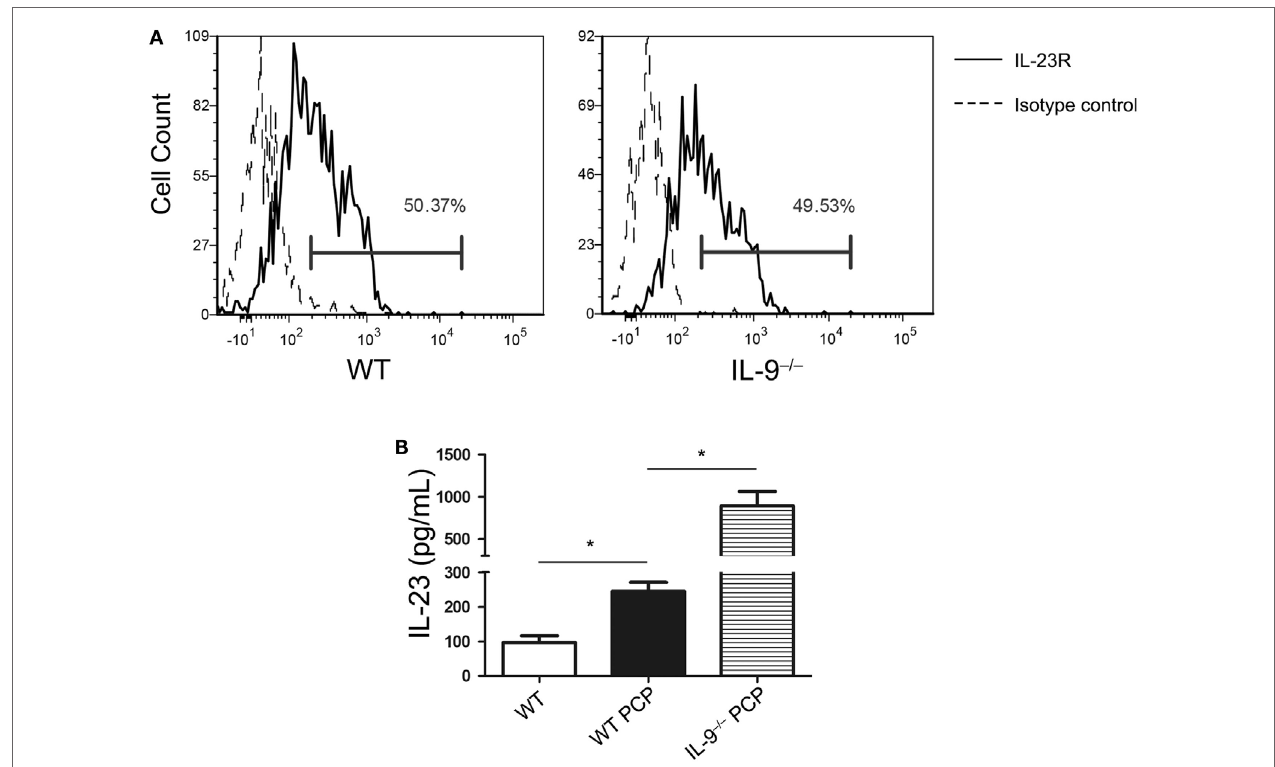
FigUre 5 | IL-23 was higher in bronchoalveolar lavage fluid (BALF) from IL-9 ‒ / ‒ Pneumocystis pneumonia (PCP) mice. (a) Cells from BALF were detected for IL-23R expression on T-helper (Th) 17 cells through Flow cytometry. About 50% of Th17 cells isolated from WT (left) and IL-9 ‒ / ‒ (right) PCP mice expressed IL-23R (solid line histogram) according to isotype control (dashed line histogram). (B) BALF was centrifuged from uninfected WT mice, WT PCP mice and IL-9 ‒ / ‒ PCP mice, and then the supernatant was examined for IL-23. Data represented mean ± SEM ( n = 4–6 per group) from three independent experiments. * P < 0.05 compared with WT PCP group by Student’s t